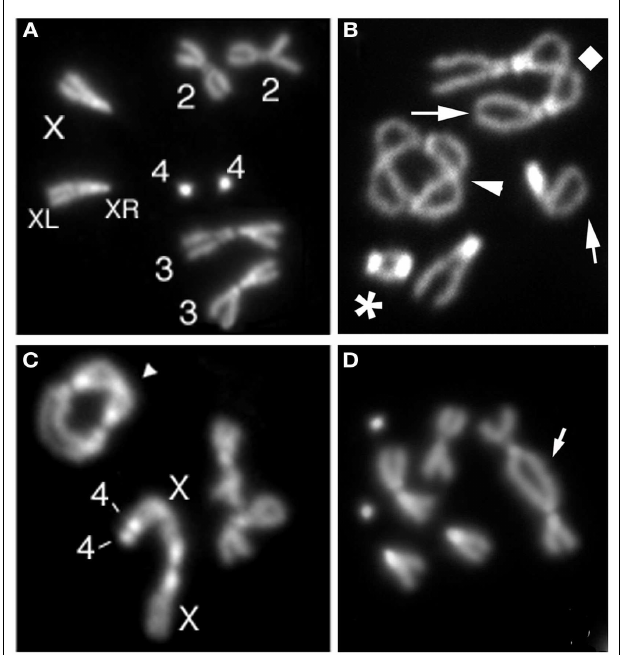
FIGURE 1 | Examples of telomeric fusions observed in Drosophila larval brains. (A) Control (Oregon R) female metaphase with a pair of chromosomes 3, 2, and 4 and two X chromosomes (XR and XL indicate short and long X chromosome arm, respectively). (B) Metaphase showing a 4–4 double telomere attachment (DTA; asterisk), a 2–2 dicentric ring chromosome (arrowhead), and a 3–3 DTA (diamond). (C) Metaphase with a multicentric chromosome generated by a 4–4-XLXR-XR DTA and a 3–3 dicentric ring (arrowhead). (D) Metaphase with a dicentric chromosome (arrow) containing a 2–2